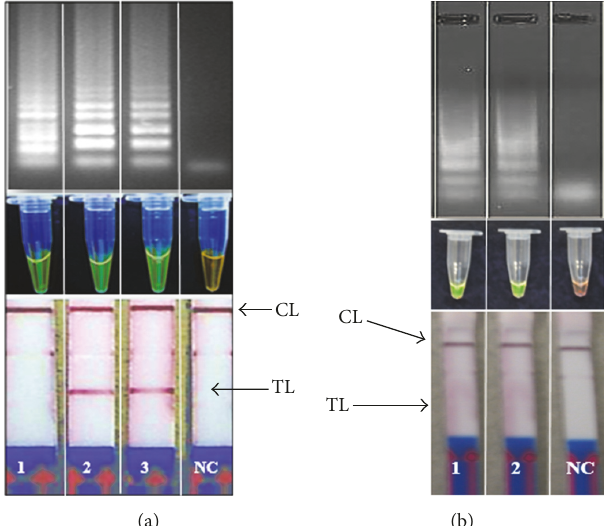
Figure 2: The detection of stem LAMP product from some selected reactions done for over 60 minutes using 2.0% agarose gels stained with ethidium bromide, SYBR Green 1 dye, and LFD dipstick format. 1 = (false positive), 2 = C. hominis , 3 = C. parvum, and NC = PCR water. (b) The appearance of nonspecific products at 75 minutes’ reaction cut-off time. 1, M044 (false positive), 2, M099 (false positive), and NC = PCR water. TL = test line; CL = control line. The nonspecific products show different patterns agarose gel and turn green on addition of SYBR Green 1. However, none was positive using the LFD format. Table 3: The comparative analysis of stem LFD LAMP, SAM-1 LAMP, and nested PCR test in the detection of previously confirmed and archived C. hominis and C. parvum DNA samples and clinical samples. Types of test Indices Stem LFD-LAMP SAM-1 LAMP a Nested PCR